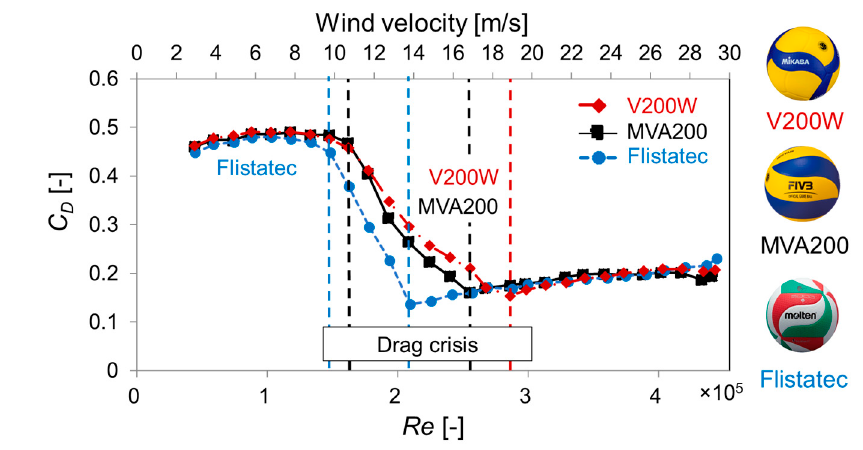
Figure 8. Relationship between Reynolds number and averaged drag coefficient on each ball.